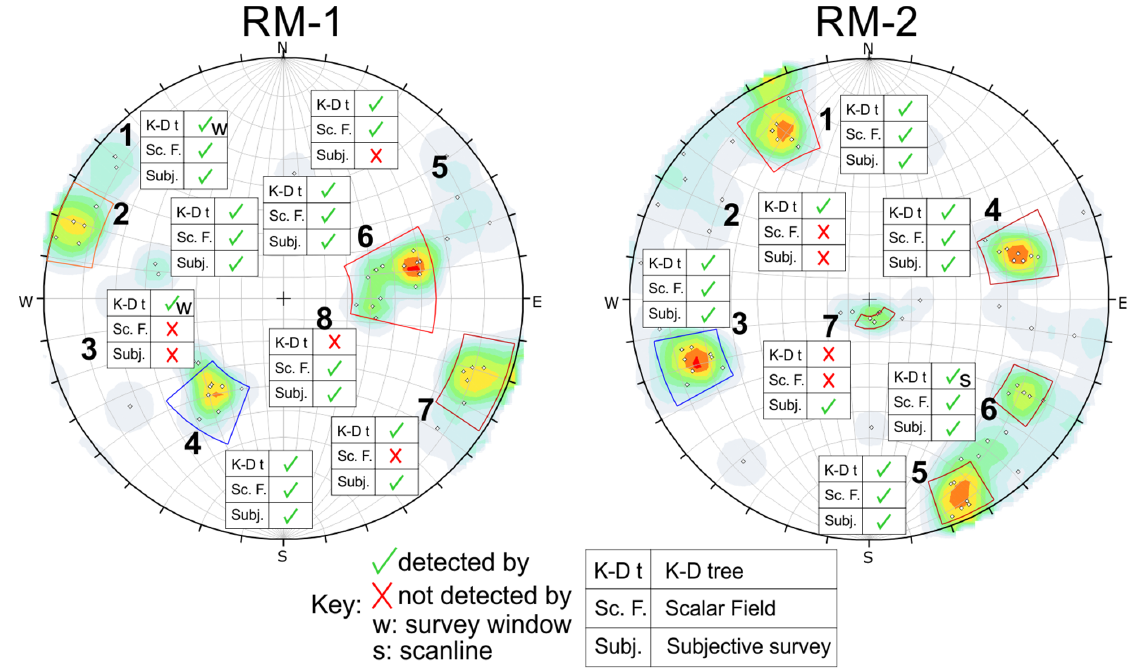
Figure 8. Field validation stereogram for the surveyed rock masses, with an overlapping schematic summary of the match with the remote discontinuity extraction approaches.